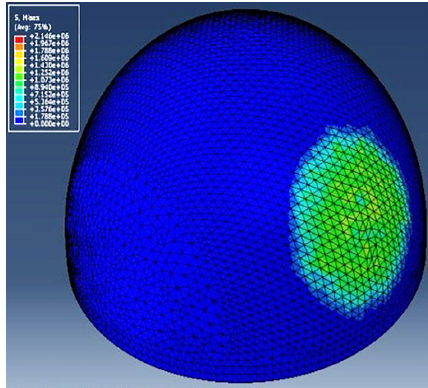
Fig. 19. Von misses composite stress contour in spherical building while explosion strikes building at height of 6 meters above the ground